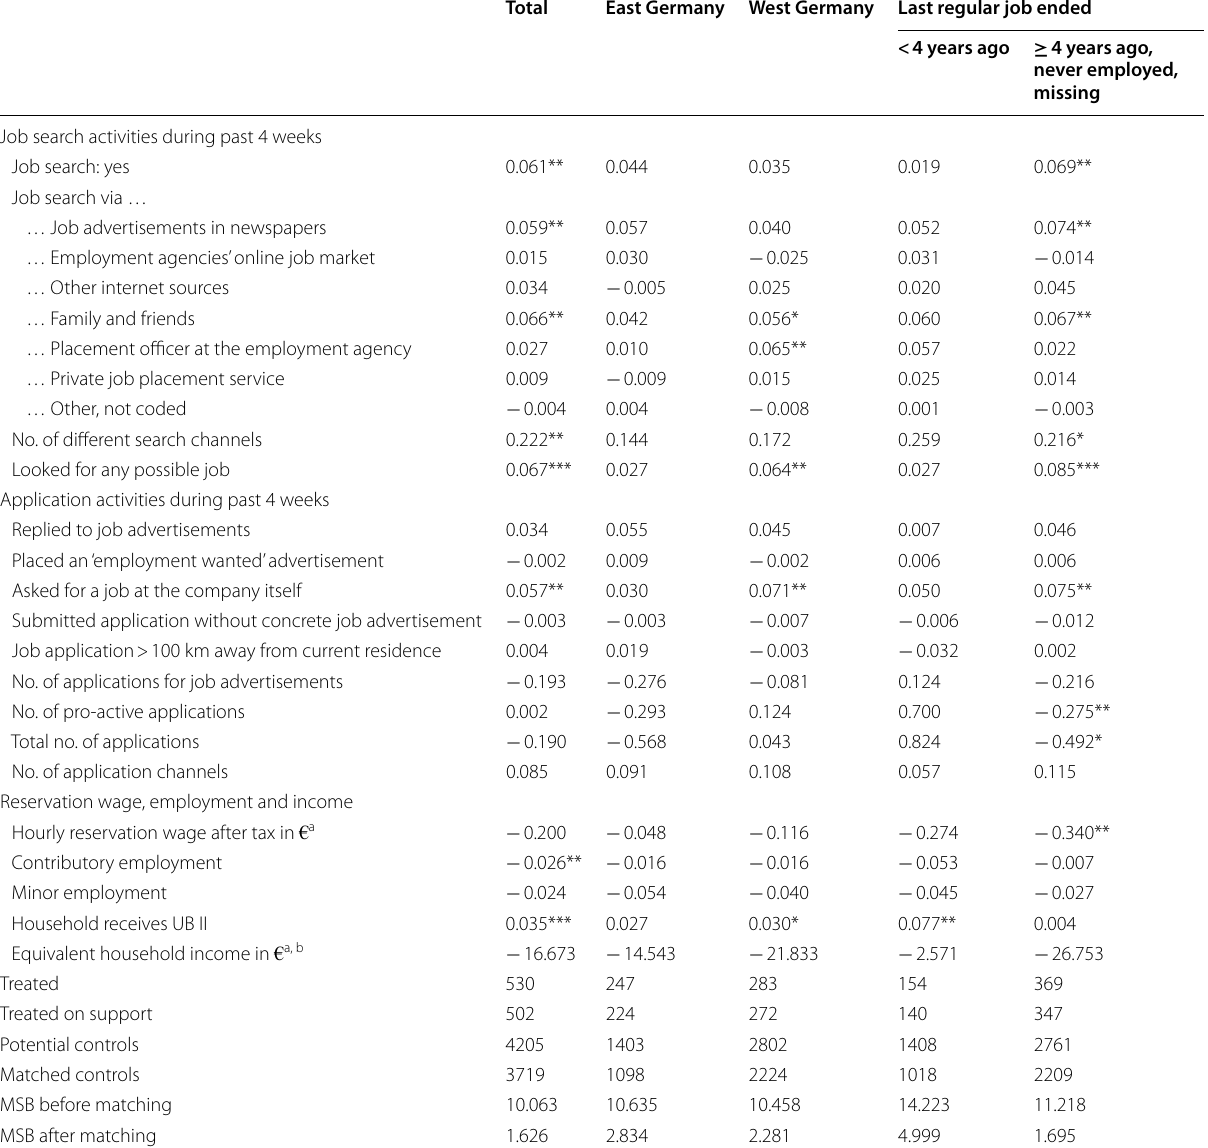
Table 9 Robustness check—ATT of receiving a One‑Euro‑Job announcement, results for first announcements.